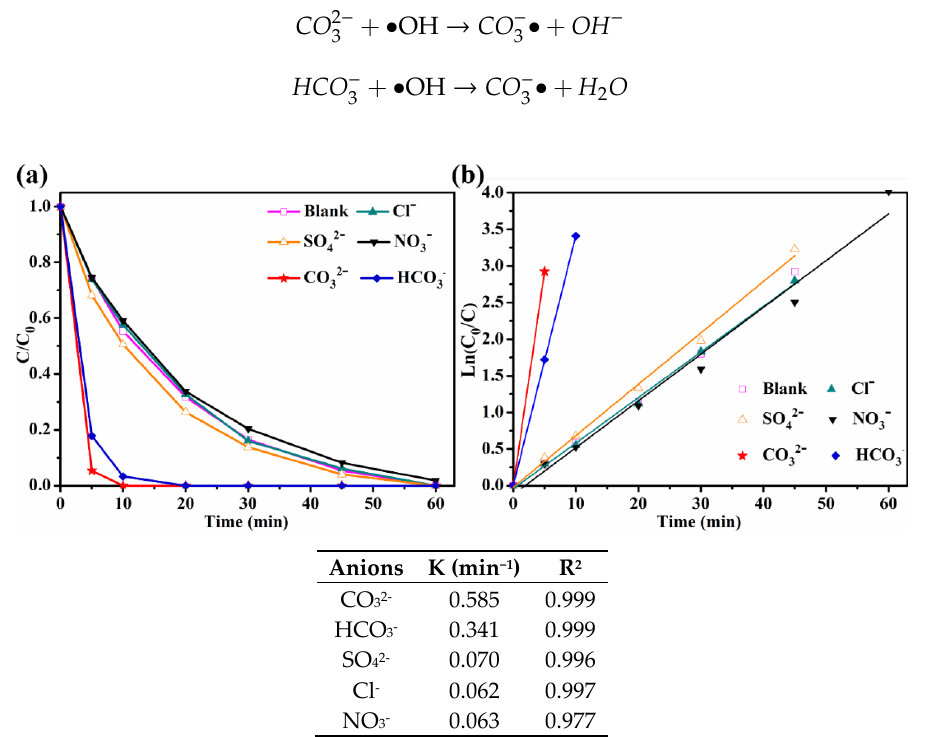
Figure 9. ( a ) Effect of co-existing anions in water on ATL degradation. ( b ) Pseudo- first-order model.